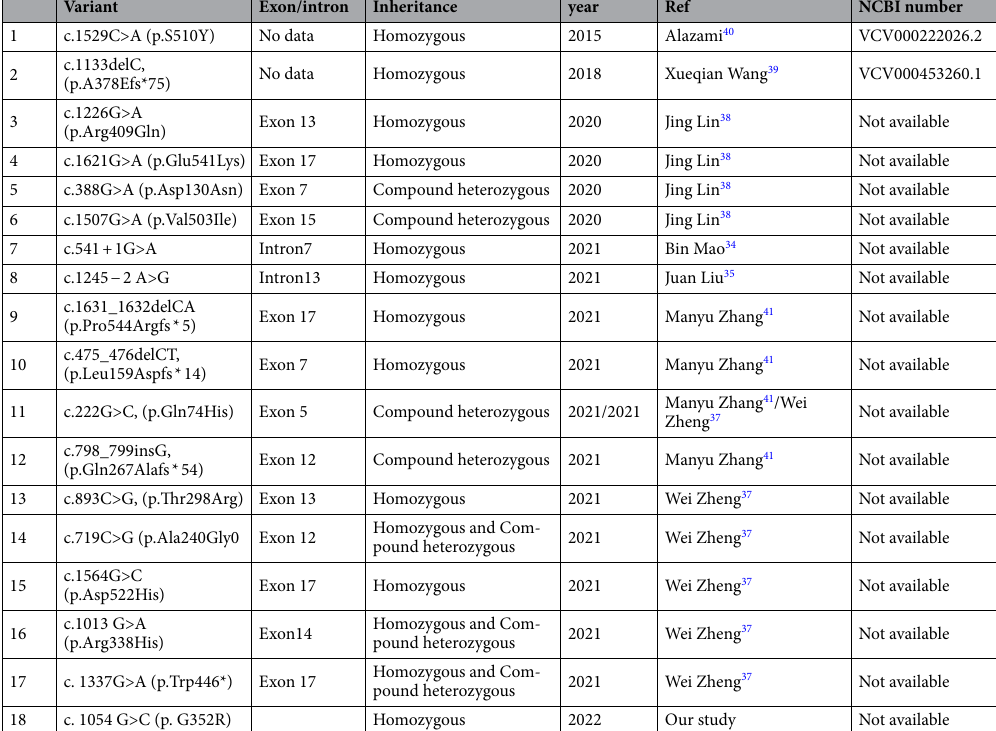
Table 3. Overview of TLE6 variants described in